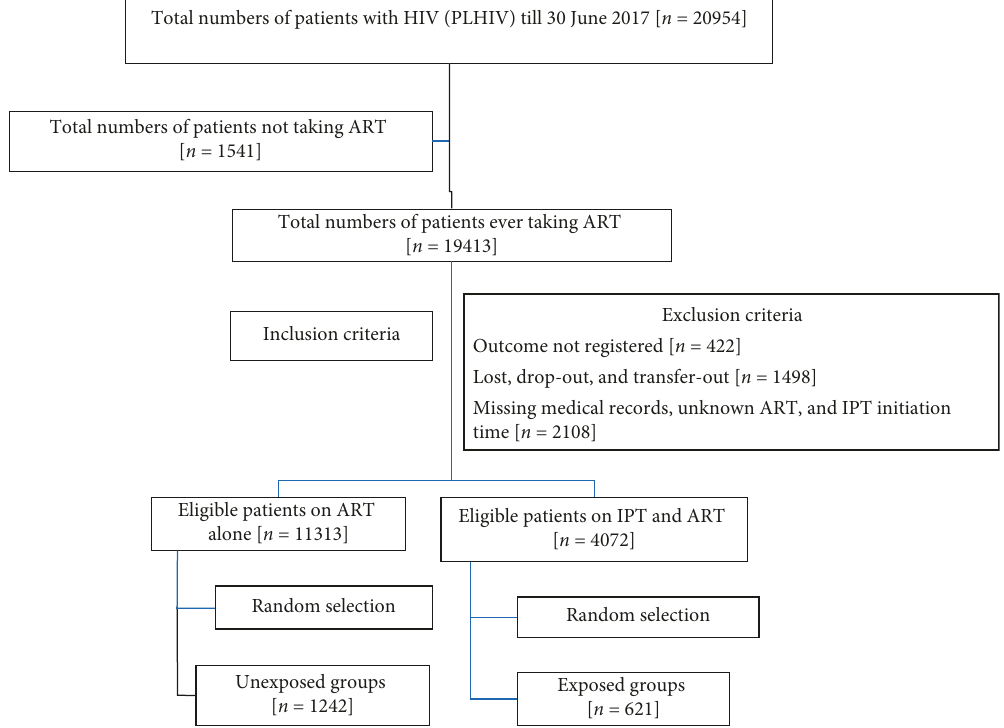
Figure 1: A flow diagram showing selection of study patients on IPT plus ART and ART alone.